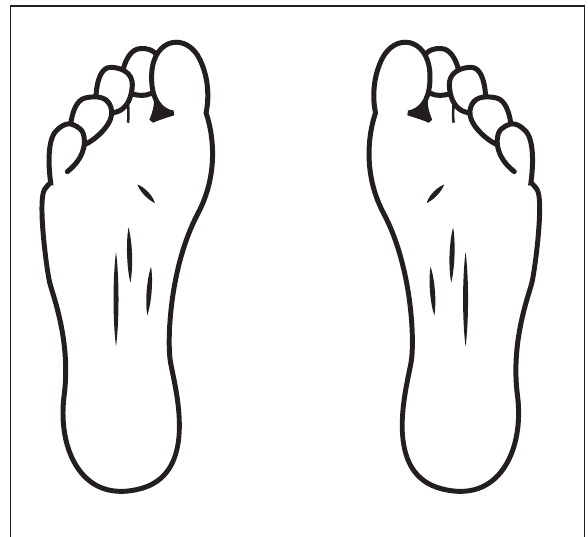
Figure 1 - Placement of the feet during data collection